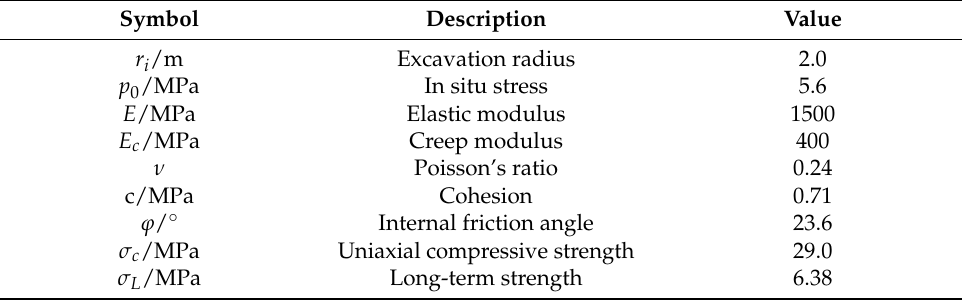
Table 2. Geometrical and mechanical parameters.